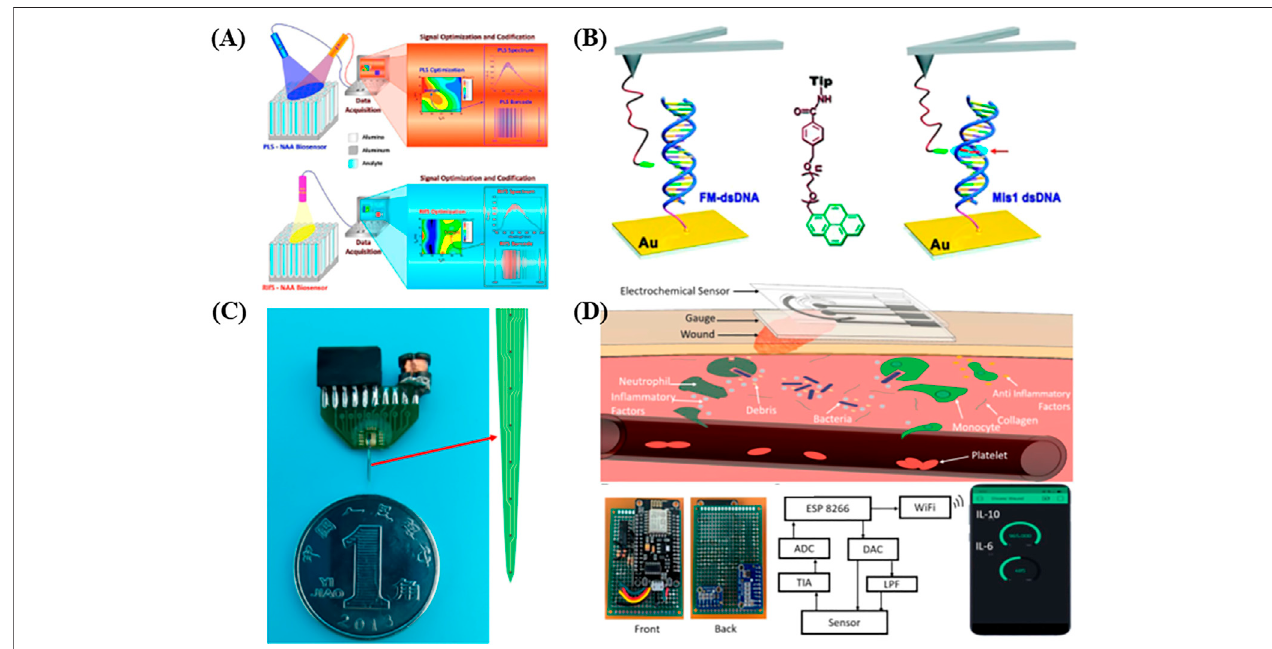
FIGURE 1 | (A) Schematic illustration of two representative sensors based on AAO nanopore thin fi lm (Feng and Ji) (B) Schematic illustration of AFM nanoprobe- enabledbiosensorformeasuringmostprobableunbindingforcesbetweenmatchedandmismatchedpairsofdsDNA(Sarkar) (C) PhotoofanOptrodepackagedonthe PCB (Li et al.) (D) Schematic illustration of the fl exible smart wound patch placed at the wound site. Photo of the front and back side of the developed IoT-enabled potentiostat. Block diagram of the IoT chronic wound analysis system (Noushin et